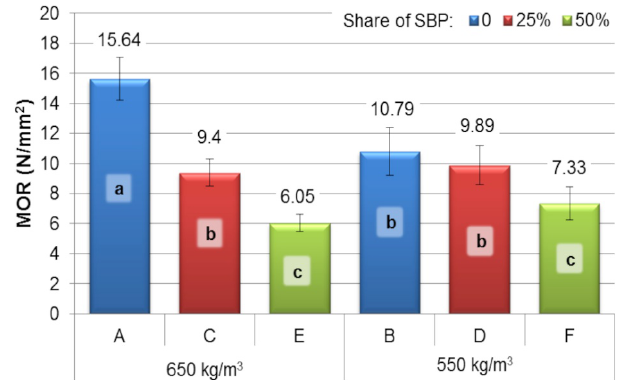
Figure 1. Modulus of rupture of particleboards. a,b,c—homogenous group by Tukey test ( α = 0.05).